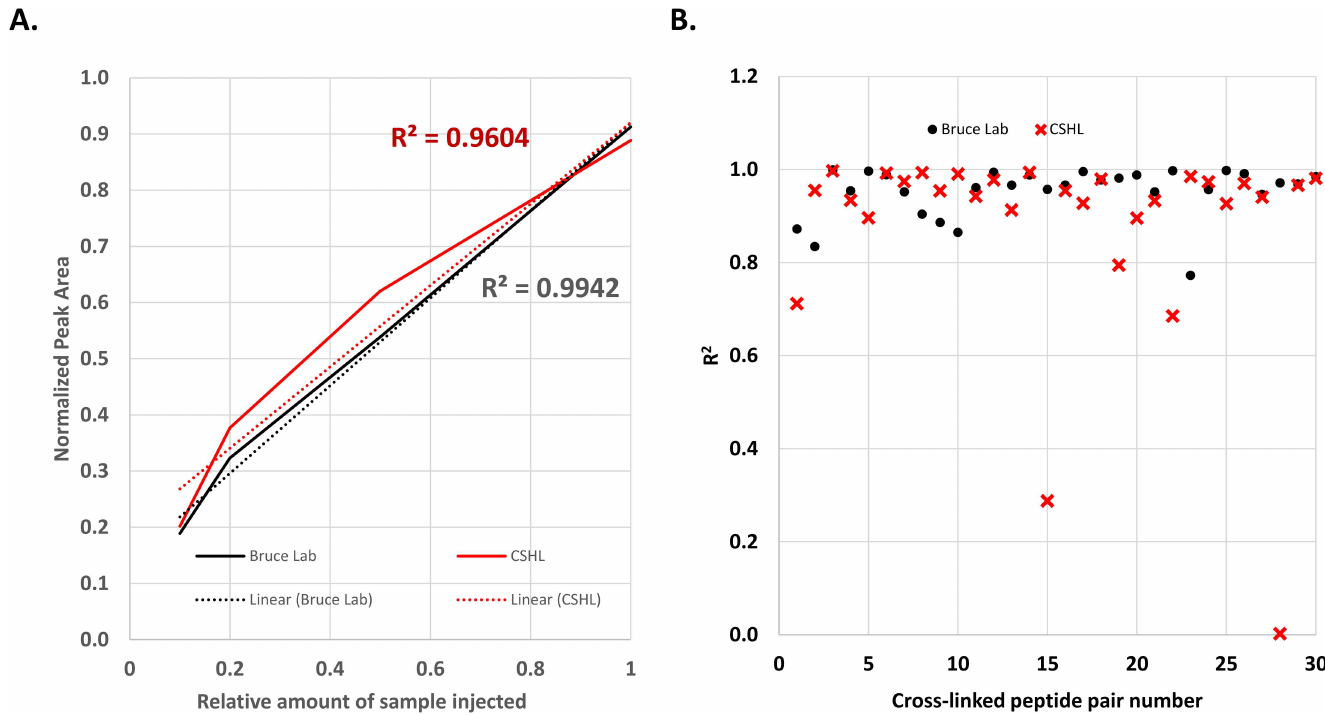
Fig 3. Cross-laboratory quantification of BSA-BDP cross-linked peptide pairs. A. Average cross-linkedpeptideresponse curve comparing data collected in the Bruce Lab and CSHL for 30 cross-linkedpeptidepairs. B. Scatter plot illustratingthe R 2 values for linear regressionanalysisof the data shown in A and